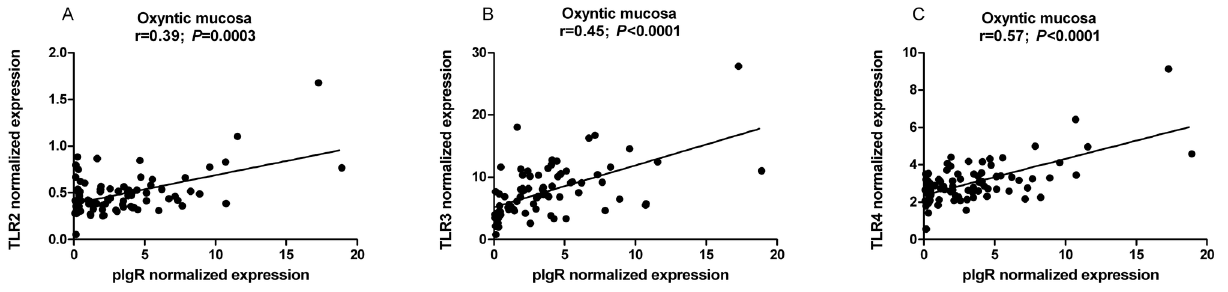
Figure 3. Pearson's correlation analysis between pIgR and TLR expressions in different gastric sites. Significant positive correlations with pIgR expression were found in the oxyntic region for TLR 2 (A), TLR3 (B), and TLR4 (C).